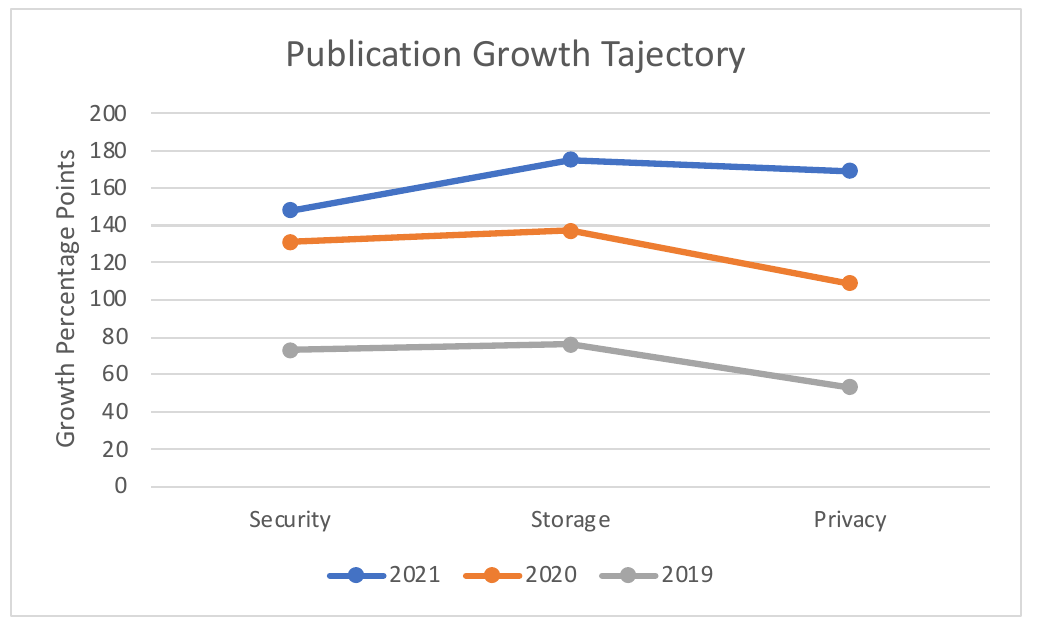
Figure 22. Comparison of Publication Growth Trajectory among Blockchain–Cloud Impact Areas.